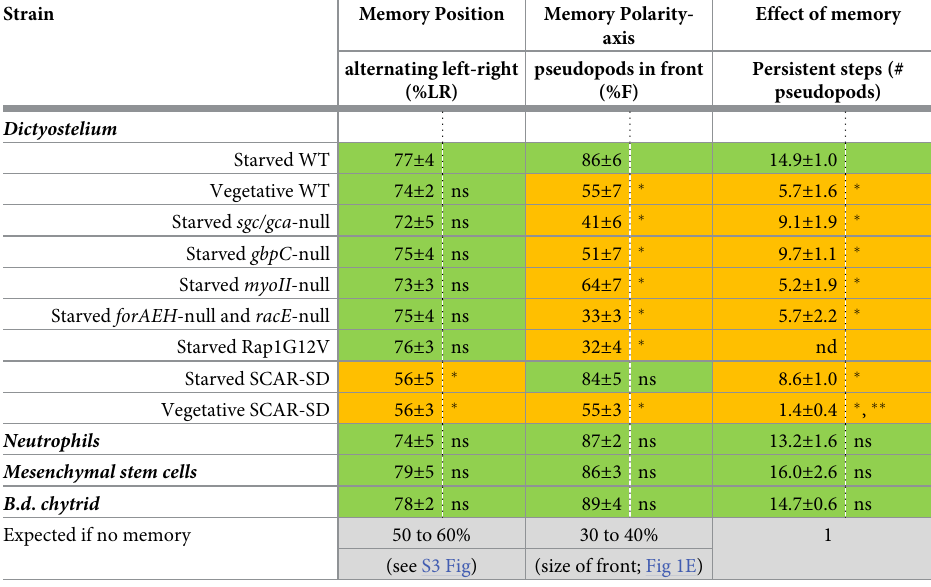
Expected if no memory (see S3 Fig) (size of front; Fig 1E) Data for memory of position and memory of polarity axis are the means and SEM; n = 28 cells for starved wild-type (WT), and n = 8 cells for others. Data for effect of memory are the optimal fit and 95% CI from S4 Fig and S1 Table. ns, not significant at P > 0.05